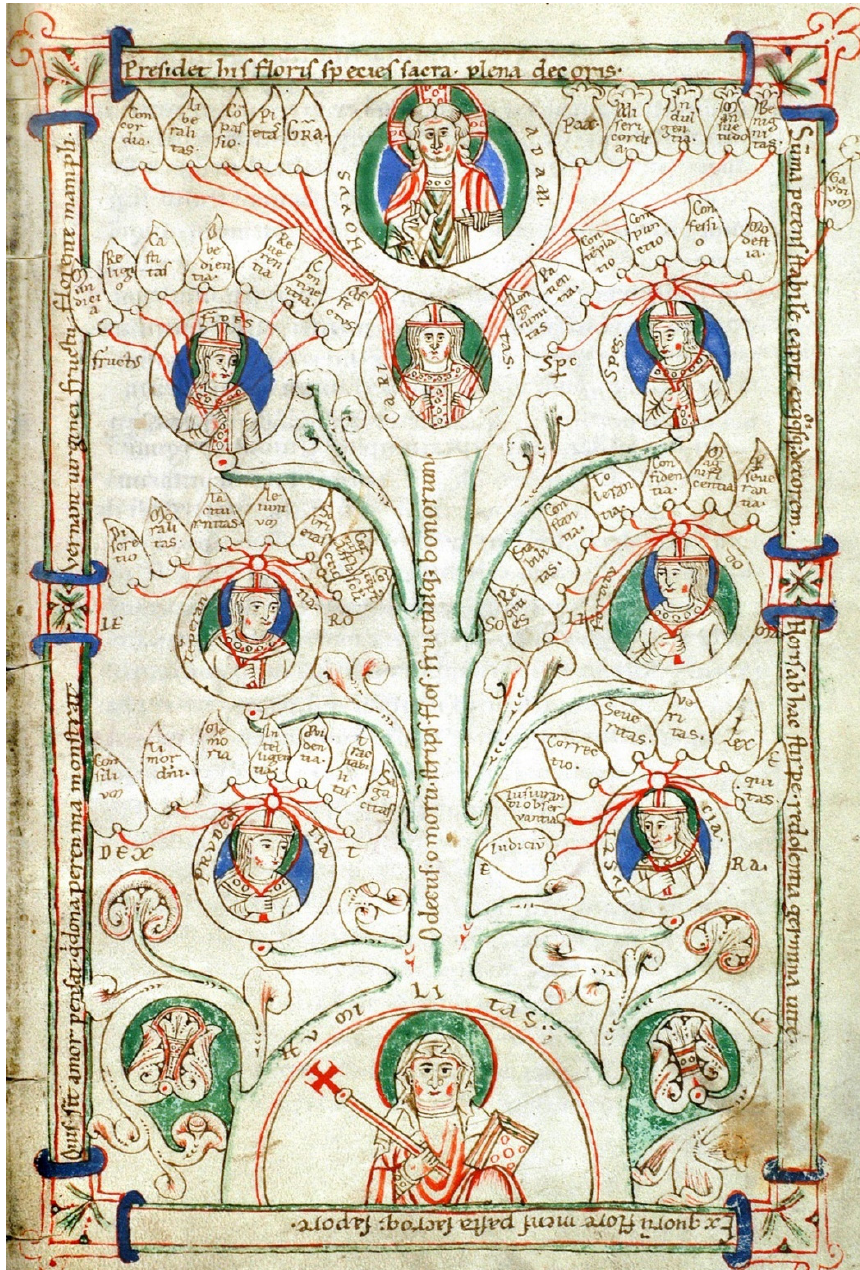
Figure 1. Tree of Virtues, De fructibus carnis et spiritus, Hugh of Saint Victor, 12th century, Salzburg, Studienbibliothek, MS. Sign. V. I. H. 162, fo. 76.